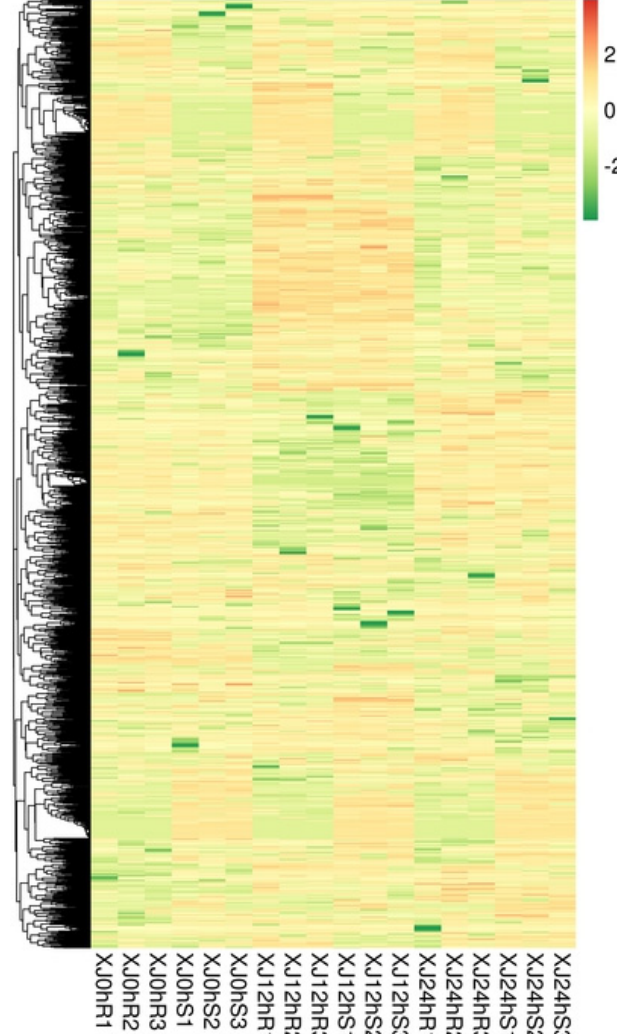
Figure 3. Differentially expressed lncRNA cluster map. Note: The figure’s columns indicate distinct samples, whereas the rows show different lncRNAs. The colour denotes the expression level of lncRNAs in the sample as log10 (FPKM + 0.000001). Table 4. The number of differentially expressed circRNAs and their